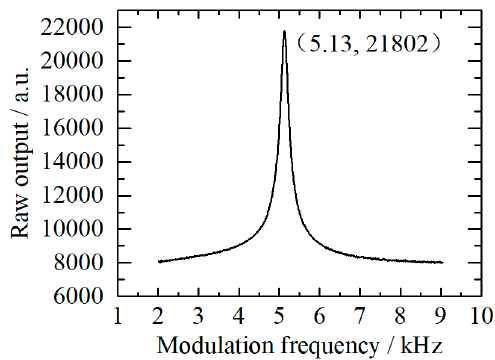
Figure 4. Amplitude-frequency response of the resonator.